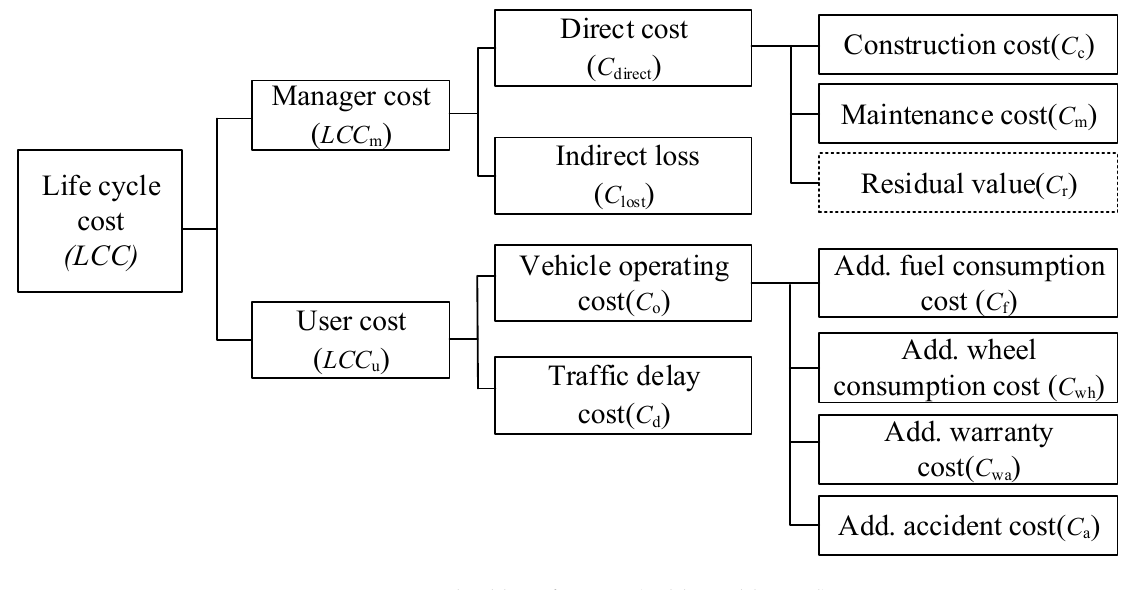
Figure 1. LCC checklist of SBDPS (Add. = additional).